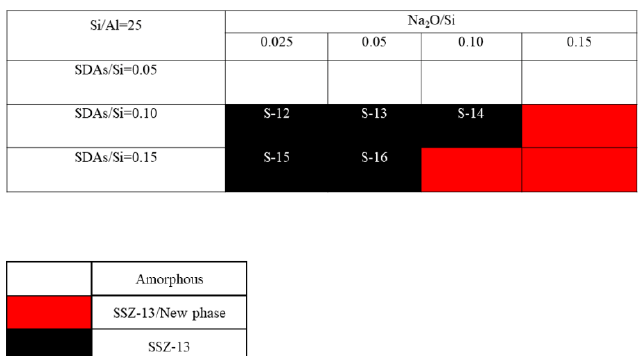
Figure 3. The crystallization of SSZ-13 with Si/Al = 25 as a function of the experimental variables in alkaline media.